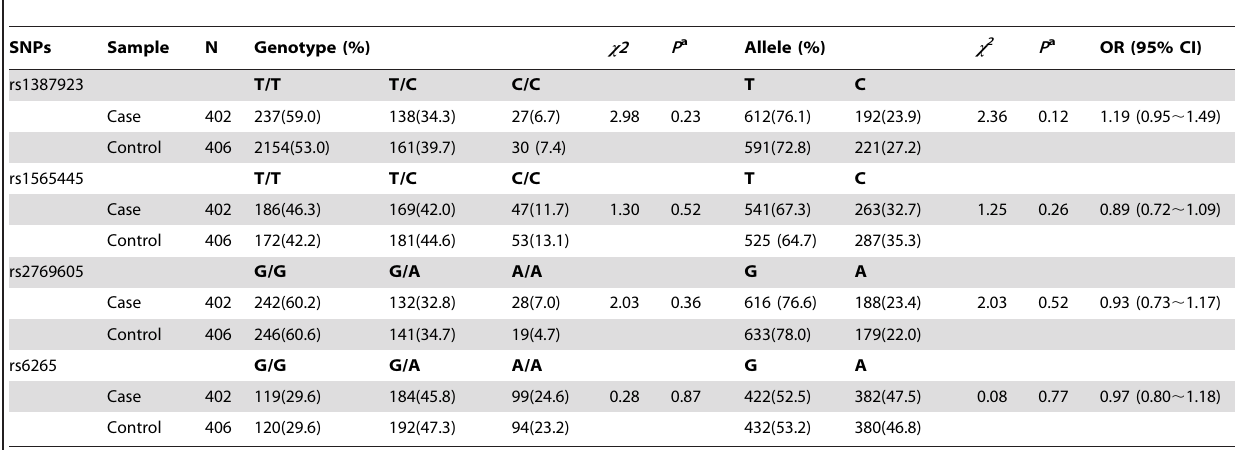
Table 2. Allele and genotype distributions of SNPs and association analysis of each SNP between Case and Control samples.